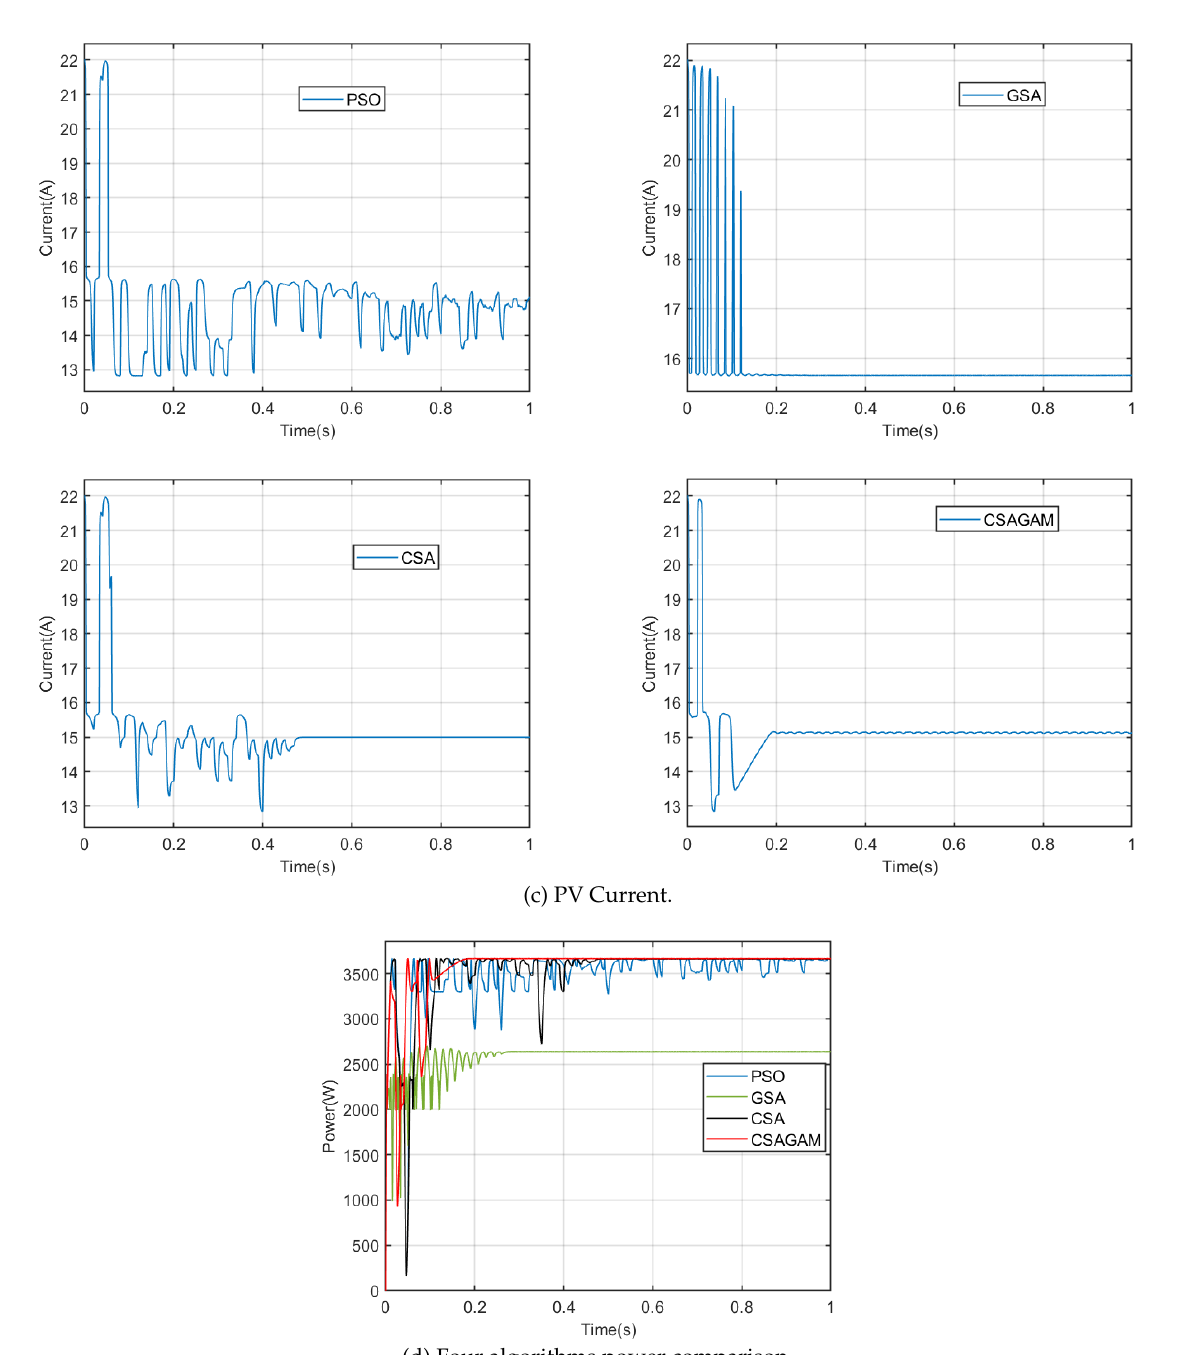
Fig. 7. Simulation results for the first partial shading case PSC 3.